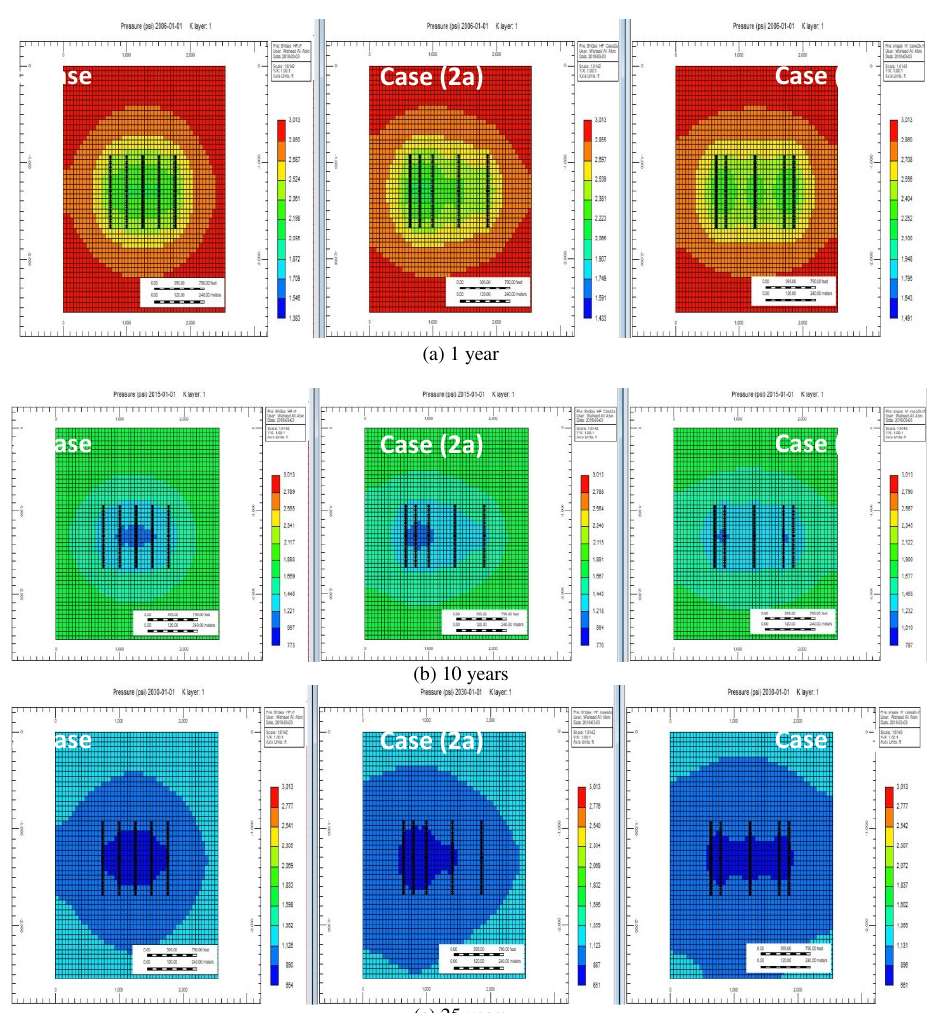
FIG. 5 COMPARISON OF PRESSURES AT DRAINAGE BOUNDARY AT DIFFERENT TIME PERIODS